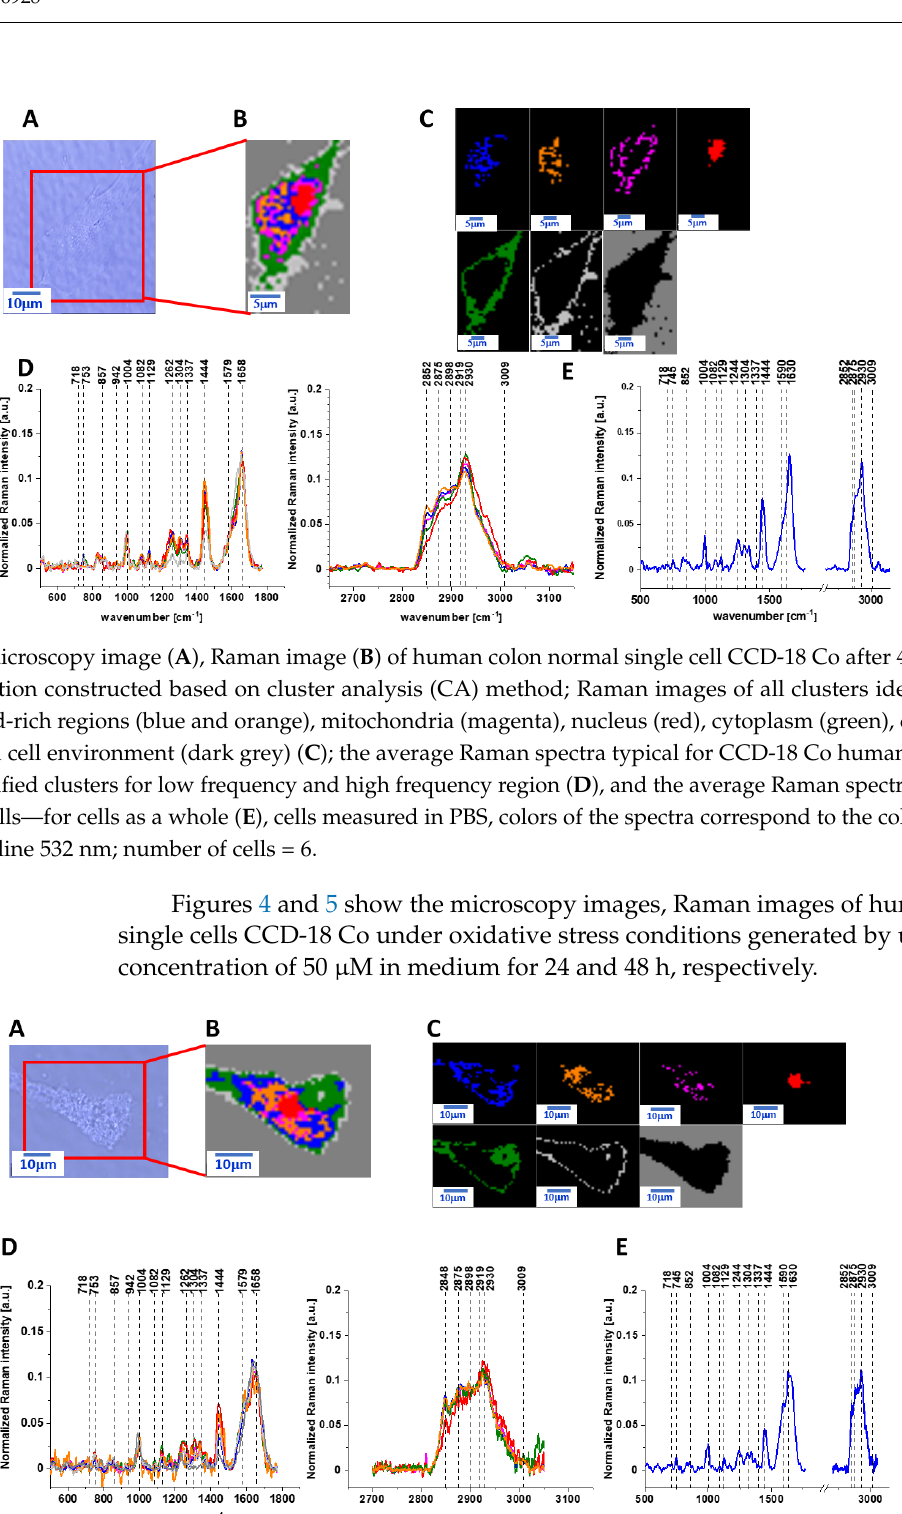
Figure 5. The microscopy image ( A ), Raman image ( B ) of human colon normal single cell CCD-18 Co under oxidative stress conditions generated by using tBuOOH for incubation time of 48 h and concentration 50 µM in medium constructed based on cluster analysis (CA) method, Raman images of all clusters identified by CA assigned to: lipid-rich regions (blue and orange), mitochondria (magenta), nucleus (red), cytoplasm (green), cell membrane (light grey), and cell environment (dark grey) ( C ), the average Raman spectra typical for CCD-18 Co human normal colon cell for all identified clusters for low frequency and high frequency region ( D ), and the average Raman spectrum for human normal colon cells — for cells as a whole ( E ), cells measured in PBS, colors of the spectra correspond to the colors of clusters, excitation laser line 532 nm, number of cells=6.